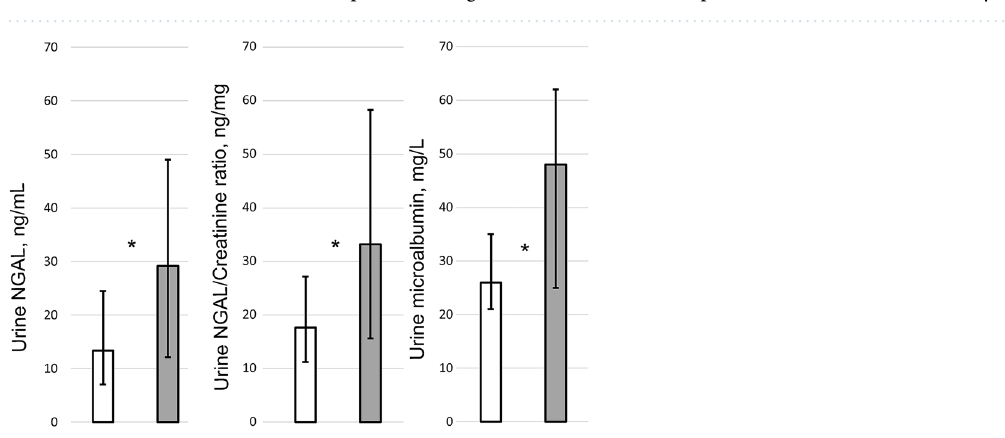
Figure 5. Bar graph showing the median urinary neutrophil gelatinase-associated lipocalin (NGAL), NGAL/ Creatinine and urine microalbumin values in intrauterine growth restriction (IUGR) (grey) and control (white) newborns. Error bars represent the upper and lower quartiles. Paired blood/urine samples were available in 75 IUGR and 66 control newborns. Urine samples alone were available in 6 IUGR and 12 control infants. *Statistically significant (P <